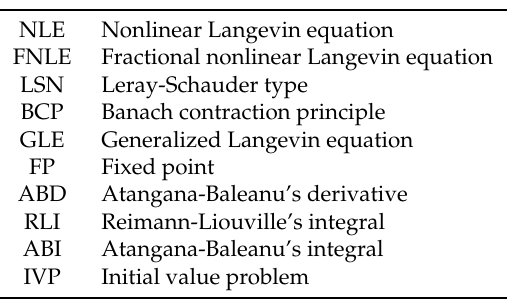
Table 1. List of